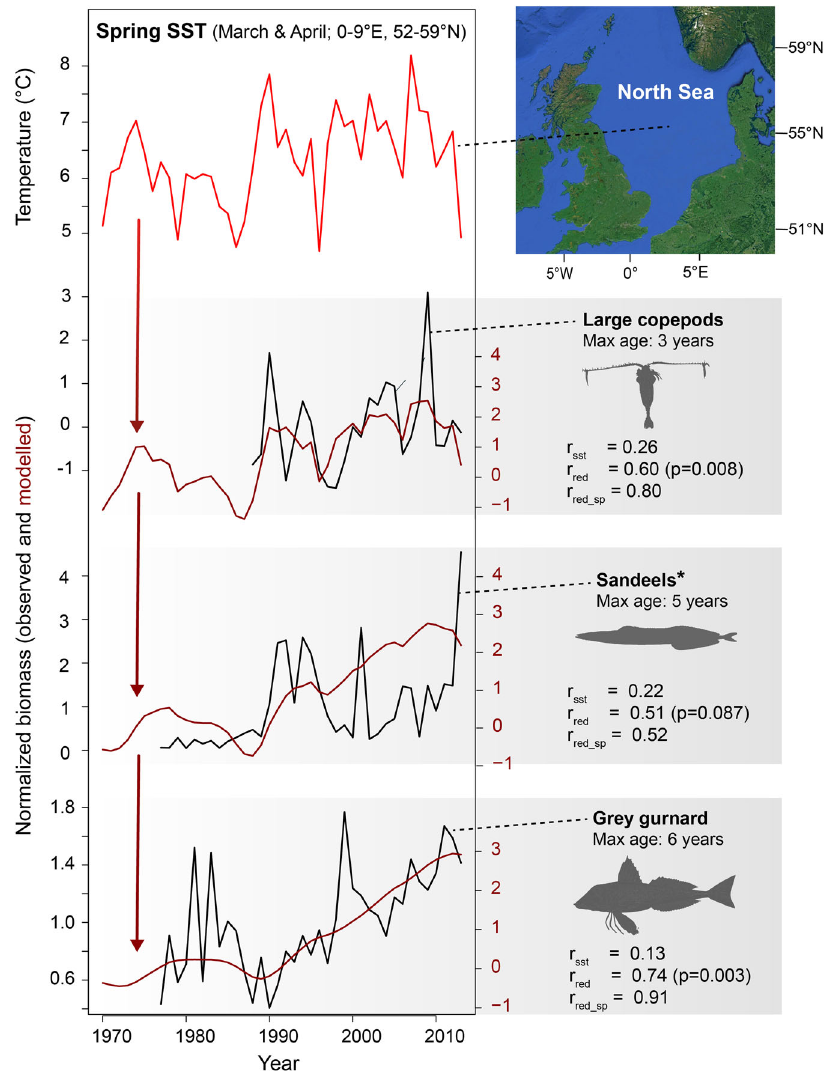
Fig. 1 Integration of interannual SST variation corresponds to low-frequency fl uctuations in biomass. In this example from the North Sea, autoregressive modelling of high-frequency sea-surface temperature (SST; red lines) generates patterns that match variations in population biomass (black lines) across three trophic levels. Results on the right show correlations at each trophic level between: spring SST data and biomass ( r sst ); auto-regressed SST and biomass ( r red ); and between a cubic smoothing spline (smoothing parameter: 0.5) through the biomass data and auto-regressed SST ( r red_sp ). The latter was included for a more direct comparison of low-frequency variability that may be masked in relatively uncertain biomass assessments. The p -values are determined using data simulations (see “ Methods ” ). *Poor association for sandeels could be caused by substantial sampling errors in assessment data 48 . Data used can be found in Supplementary Data fi les 1 and